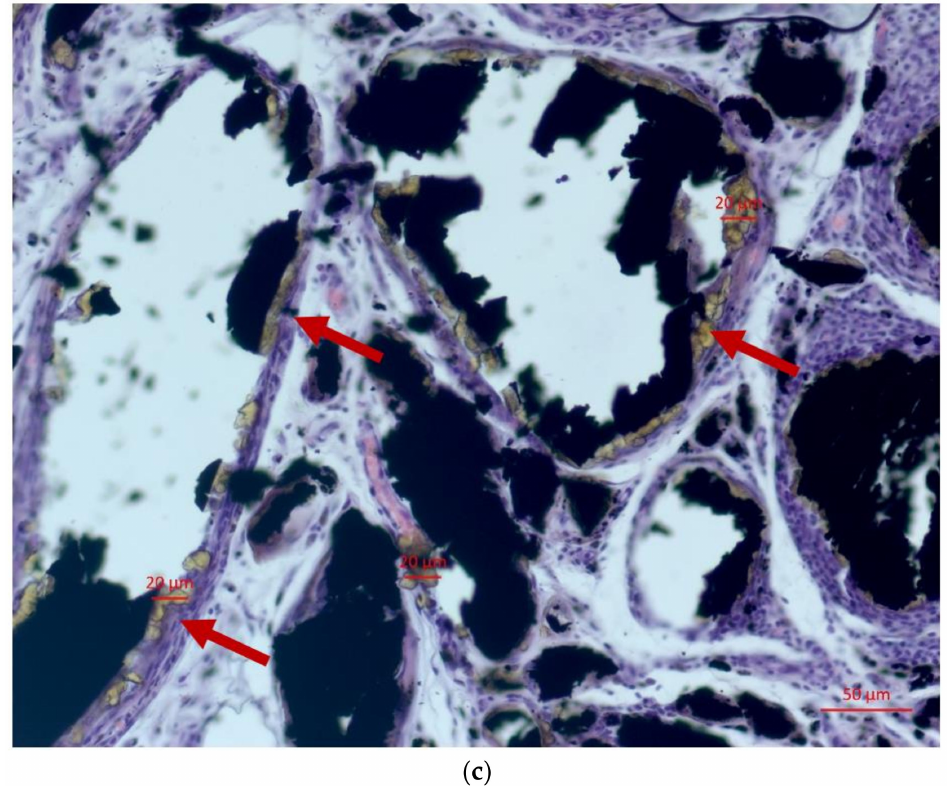
Figure 2. Areas of the fringing phenomenon around the modified Fe@C NPs in the fat tissue of a laboratory animal at 7 ( a ), 14 ( b ), and 21 ( c ) days of the experiment. Red arrows indicate the presence of a fringing